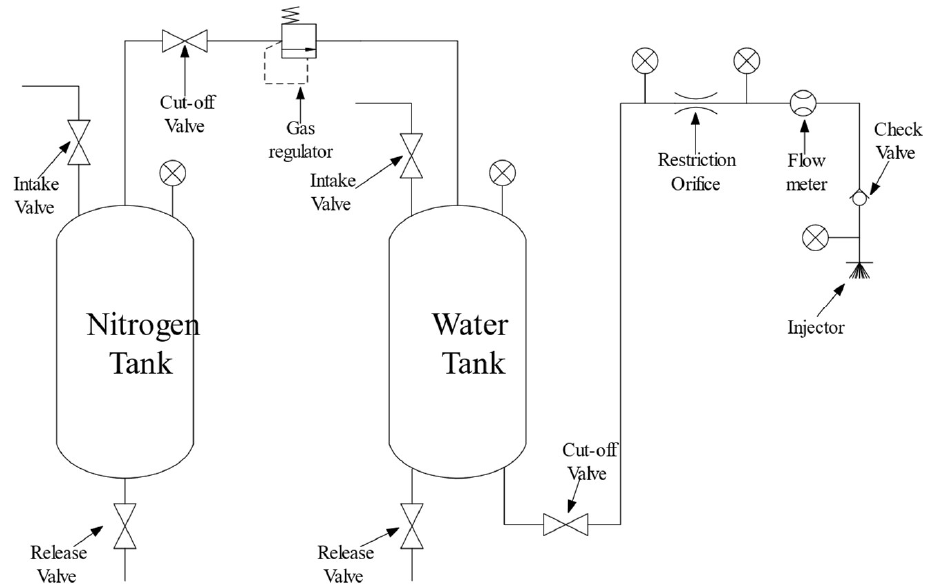
Figure 1. Sketch of the experimental system.